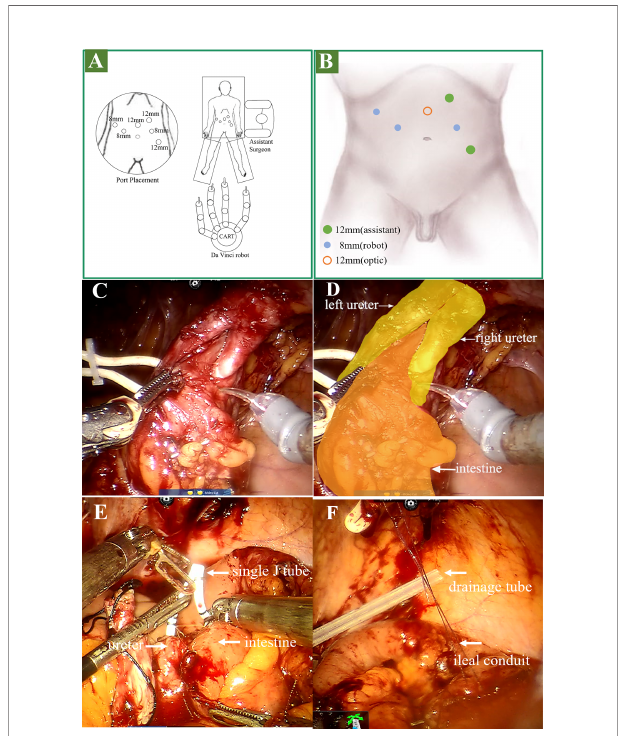
FIGURE 2 | Operation procedure. (A, B) stage 1 surgical position and port placement. (C, D) stage 2: lysis of adhesions and dissociation of the ureter. (E) stage 3: placed the single J stent. (F) stage 3: suspended the outlet of the ileal conduit to the